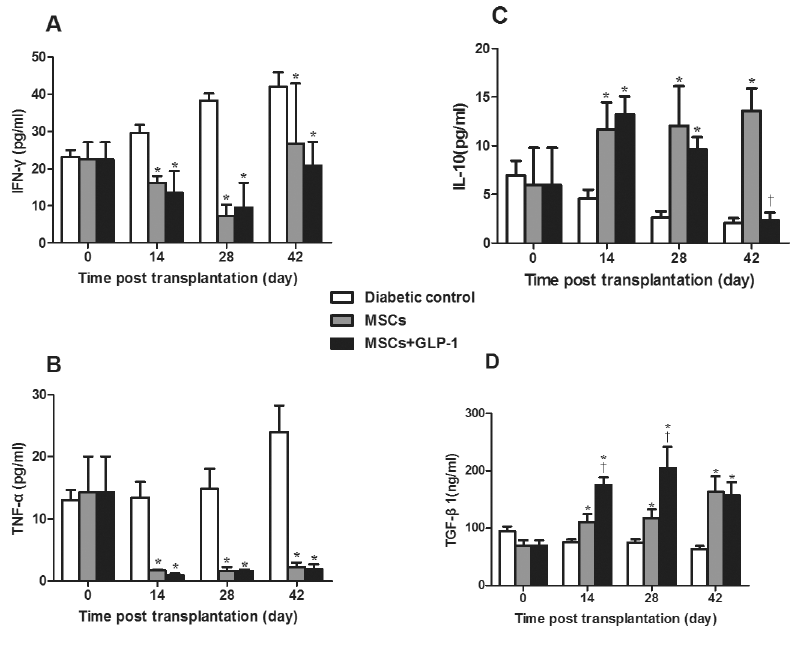
Figure 5. Treatment with MSCs and GLP-1 alters plasma cytokine levels in NOD mice. Following treatment with MSCs and GLP-1, plasma IFN- γ , TNF- α , IL-10 and TGF- β 1 levels in individual mice were measured. Data are expressed as the mean ± SEM of individual group of mice (n = 6 per group per time point) from three separate experiments. (A) Plasma IFN- γ levels. (B) Plasma TNF- α levels. (C) Plasma IL-10 levels. (D) Plasma TGF- β 1 levels. * P < 0.05 versus diabetic controls. † P < 0.05 versus mice treated with MSCs